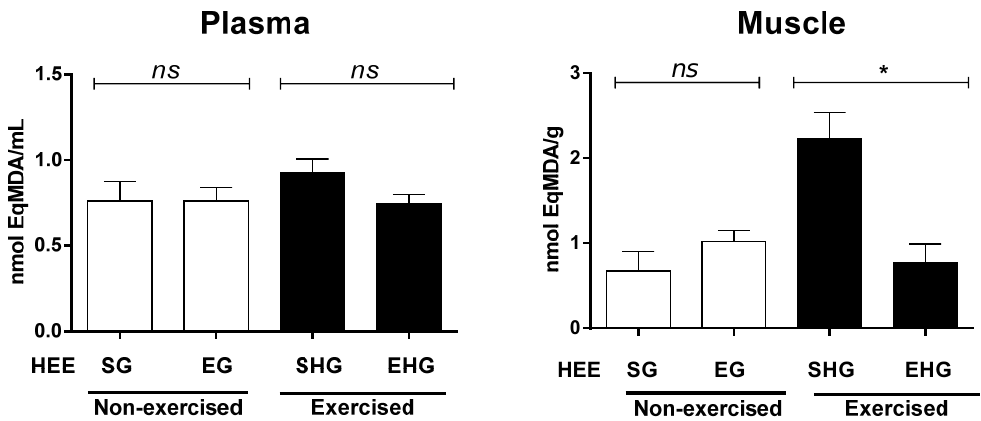
Figure 4. Concentration of malondialdehyde in animals subjected to the administration of hydroethanolic extract of C. argyrophyllus (EHE) and further execution of acute resistance exercise. ns: not significant; * differences between the exercised groups. The results are shown as mean ± SEM. One ‐ way ANOVA with a Bonferroni post test; p < 0.05. SG—sedentary vehicle group; EG— exercise vehicle group; SHG—sedentary group HEE; EHG—HEE exercise group.